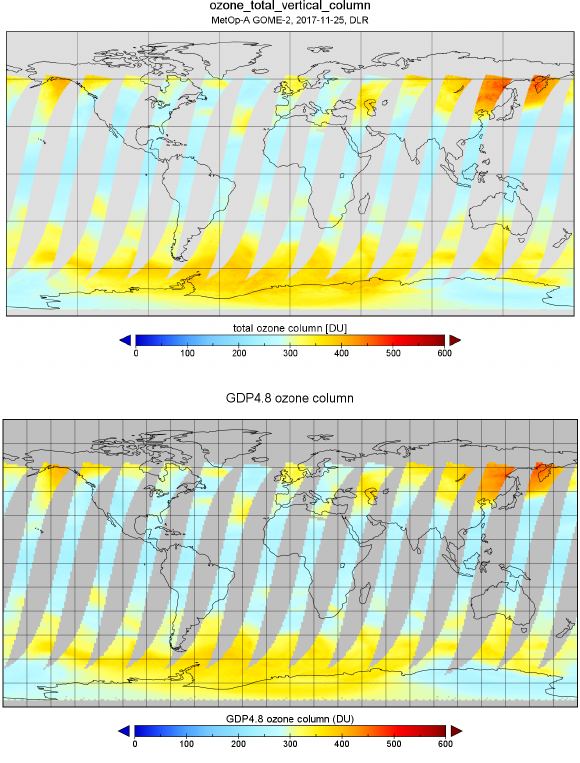
Figure 2. Comparison of retrieved total O 3 columns from GOME-2A data between the DOAS retrieval using the FP-ILM profile (top) and the GDP 4.8 product (bottom) on November